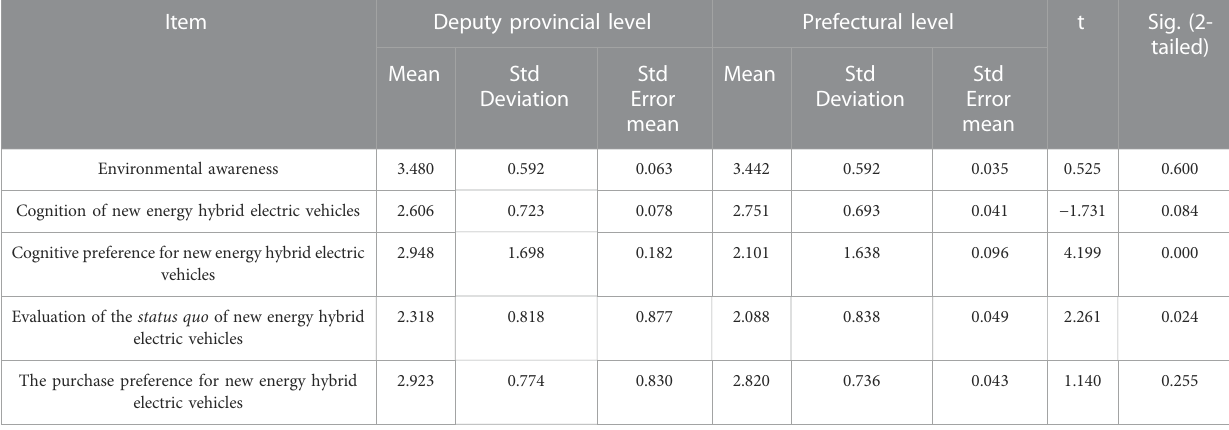
TABLE 6 T-test results of independent samples in different